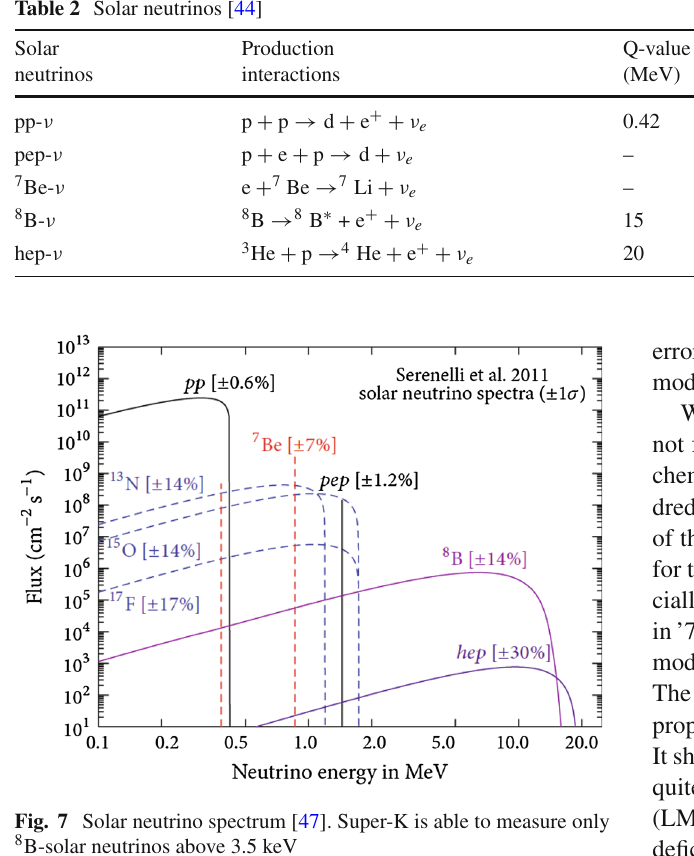
It is easily obtained from the elementary process in the sun and the solar luminosity that the total solar neutrino flux is of 6 . 6 × 10 10 cm − 2 s − 1 at the top of the atmosphere of the earth. Individual fluxes of pp, pep, 7 Be, 8 B and hep neutrinos cal- culated by the solar model [44] are also listed in Table 2.